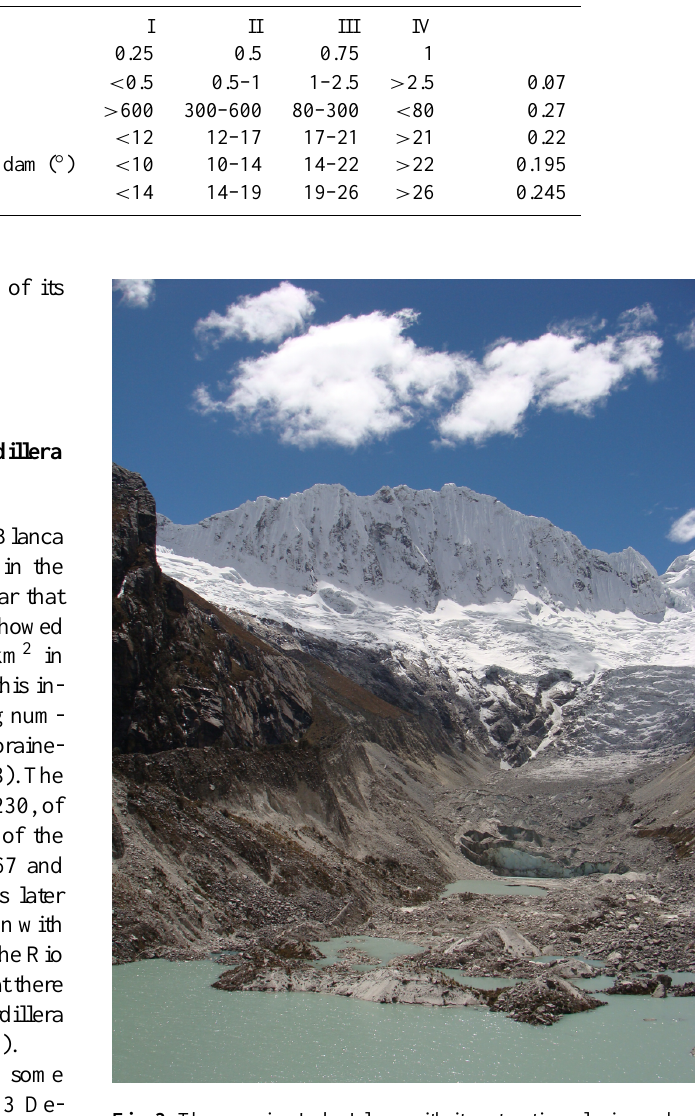
Fig. 3. The growing Lake Llaca with its retreating glacier and pro- truding basal